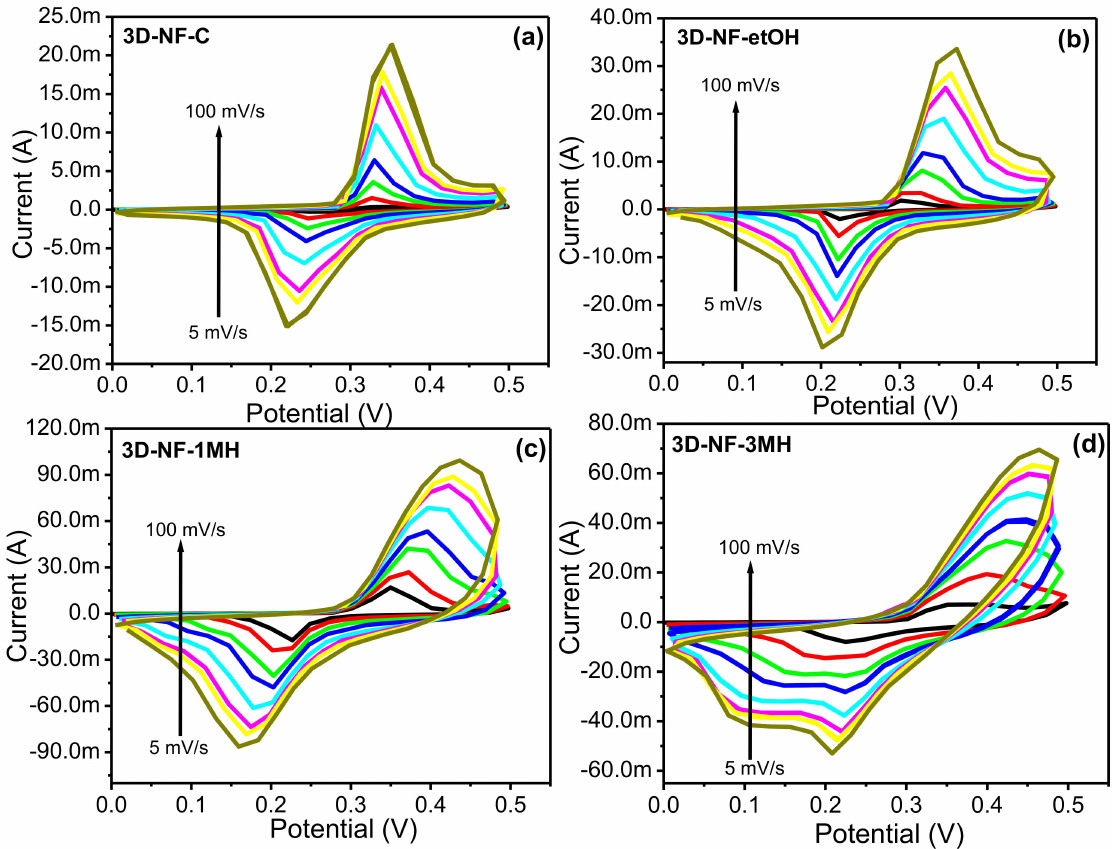
Figure 4. CV graph of the ( a ) 3D-NF-C; ( b ) 3D-NF-etOH; ( c ) 3D-NF-1MH; and ( d ) 3D-NF-3MH electrodes at different scan